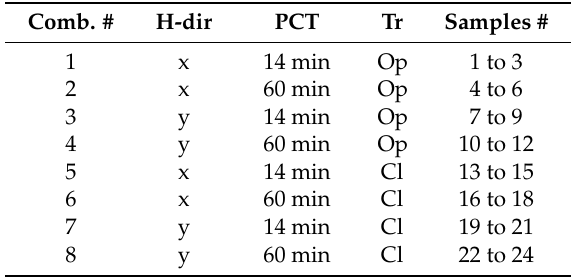
Table 2. Combination (Comb) of constructive settings for samples according to DOE. Comb. #